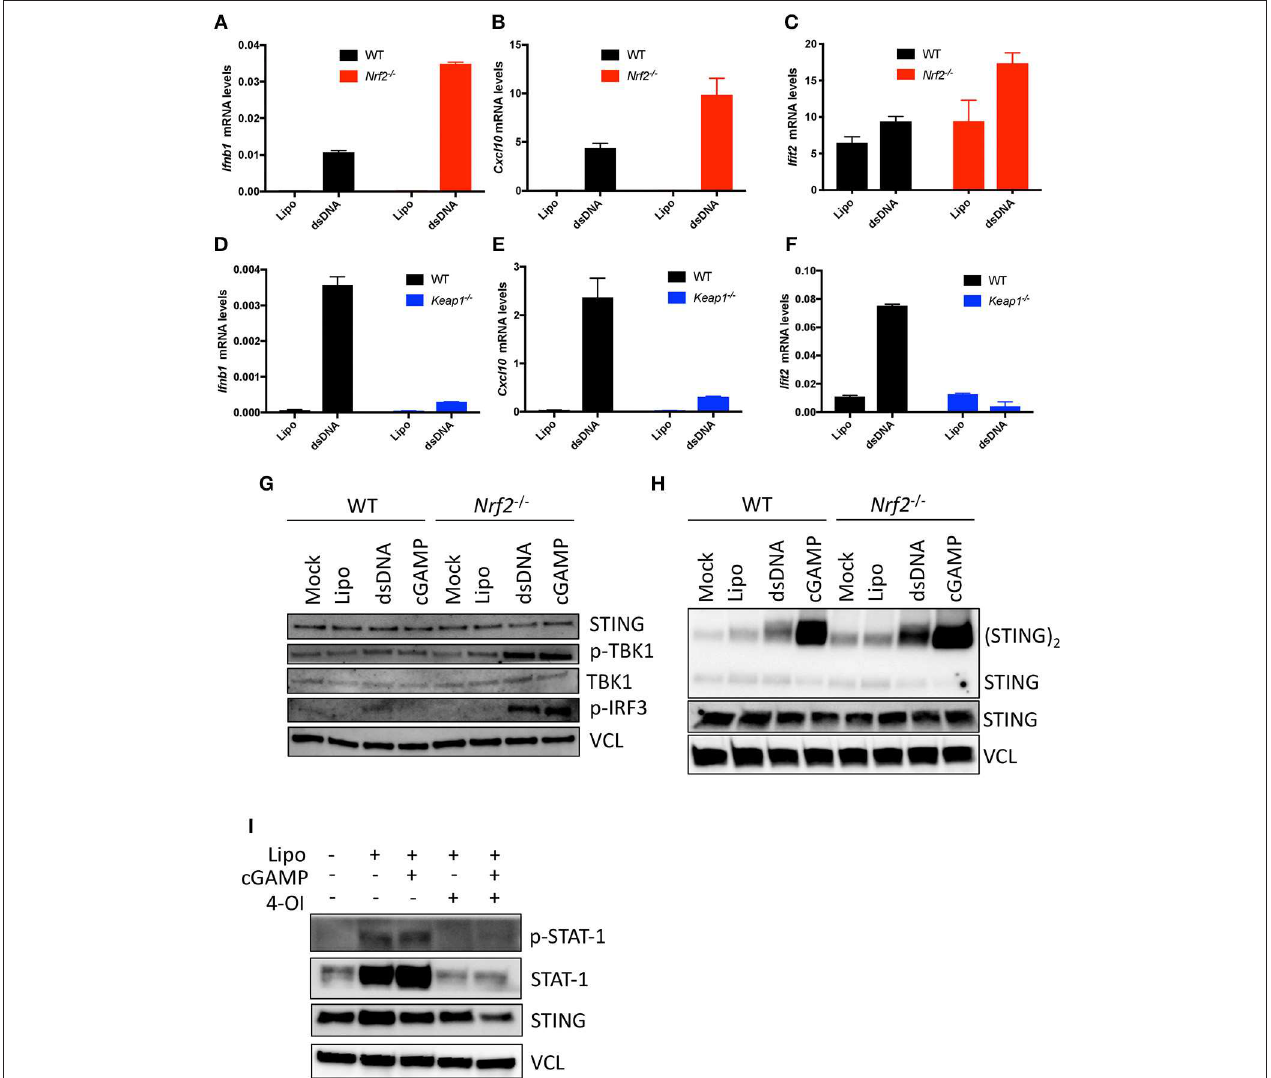
FIGURE 3 | Nrf2 impairs antiviral innate immunity following HSV-DNA or cGAMP stimulation. (A–C) WT and Nrf2 KO BMMs and WT and (D–F) Keap1 KO MEFs were transfected for 6h with Lipofectamine 2000 (Lipo.) alone or in combination with HSV-derived dsDNA (dsDNA) (4 µ g.mL − 1 ). RNA was isolated and analyzed for the levels of Ifn β 1 , Cxcl10, and Ifit2 mRNA by qPCR. Data are the means ± SEM where each panel is representative of one experiment performed in duplicate or triplicate. (G–H) WT or Nrf2 KO BMMs were transfected for 3h with Lipofectamine 2000 alone or in combination with dsDNA or cGAMP (4 µ g.mL − 1 ) and